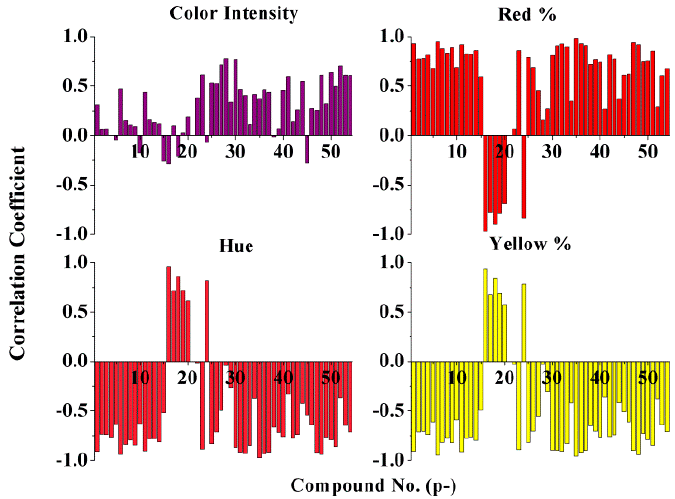
Figure 5. Correlation coefficients of color parameters with phenolic compounds.